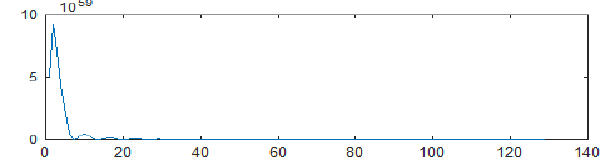
Figure 6: psd of output in THz range due to Third Harmonic wave